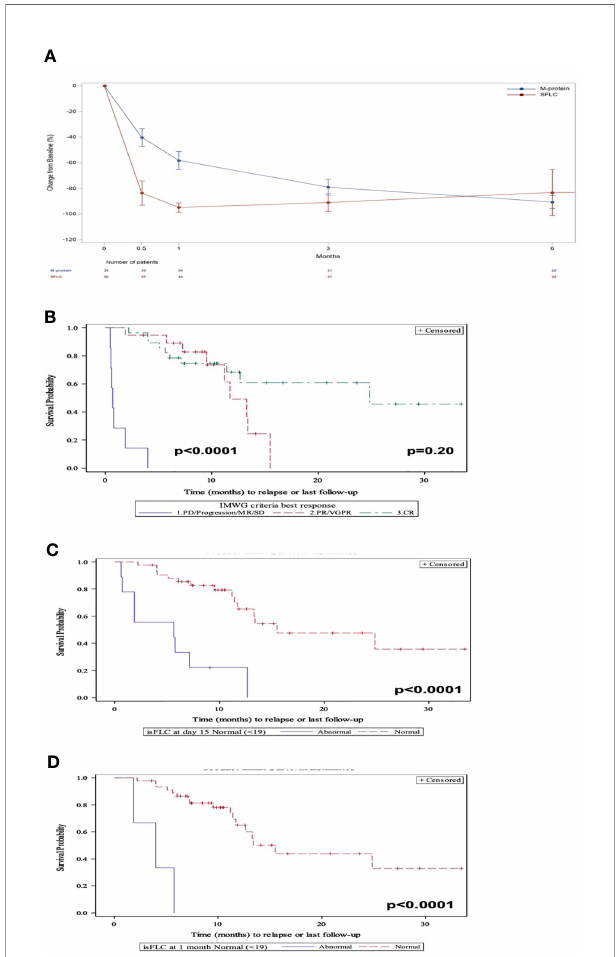
FIGURE 1 | (A) Evolution of the M-protein and involved SFLC after CAR-T therapy in responders. (B) PFS by IMWG response criteria. (C) PFS at 15 days post-CAR-T by elevated iSFLC vs . nonelevated iSFLC. (D) PFS at 30 days post-CAR-T by elevated iSFLC vs . nonelevated iSFLC.